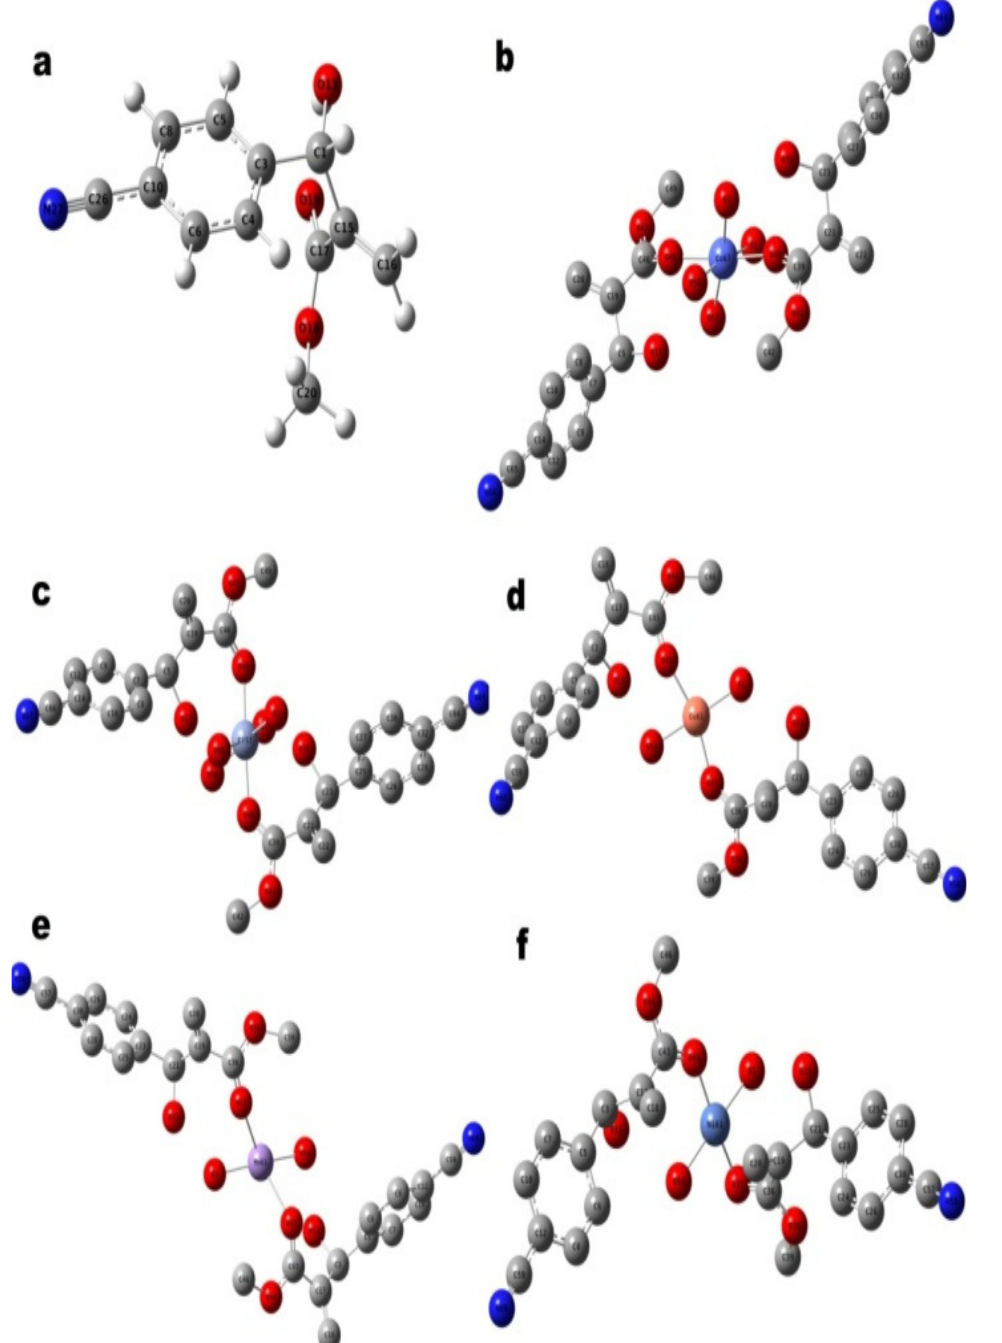
Figure 3. Theoretically Optimized Geometries of ( a ) MBHA (L ”x ), and its Corresponding Complexes, ( b ) CoL ”x , ( c ) CrL ”x , ( d ) CuL ”x , ( e ) MnL ”x and ( f ) NiL ”x . The results have confirmed that each metal is coordinated by two ligand molecules. Cr +3 , Co +3 are octahedral and Ni +2 is square planner, whereas, Mn +2 and Cu +2 are tetrahedral as per optimized geometrical structures. Hydrogen atoms are removed from metal complexes for geometry clarity.